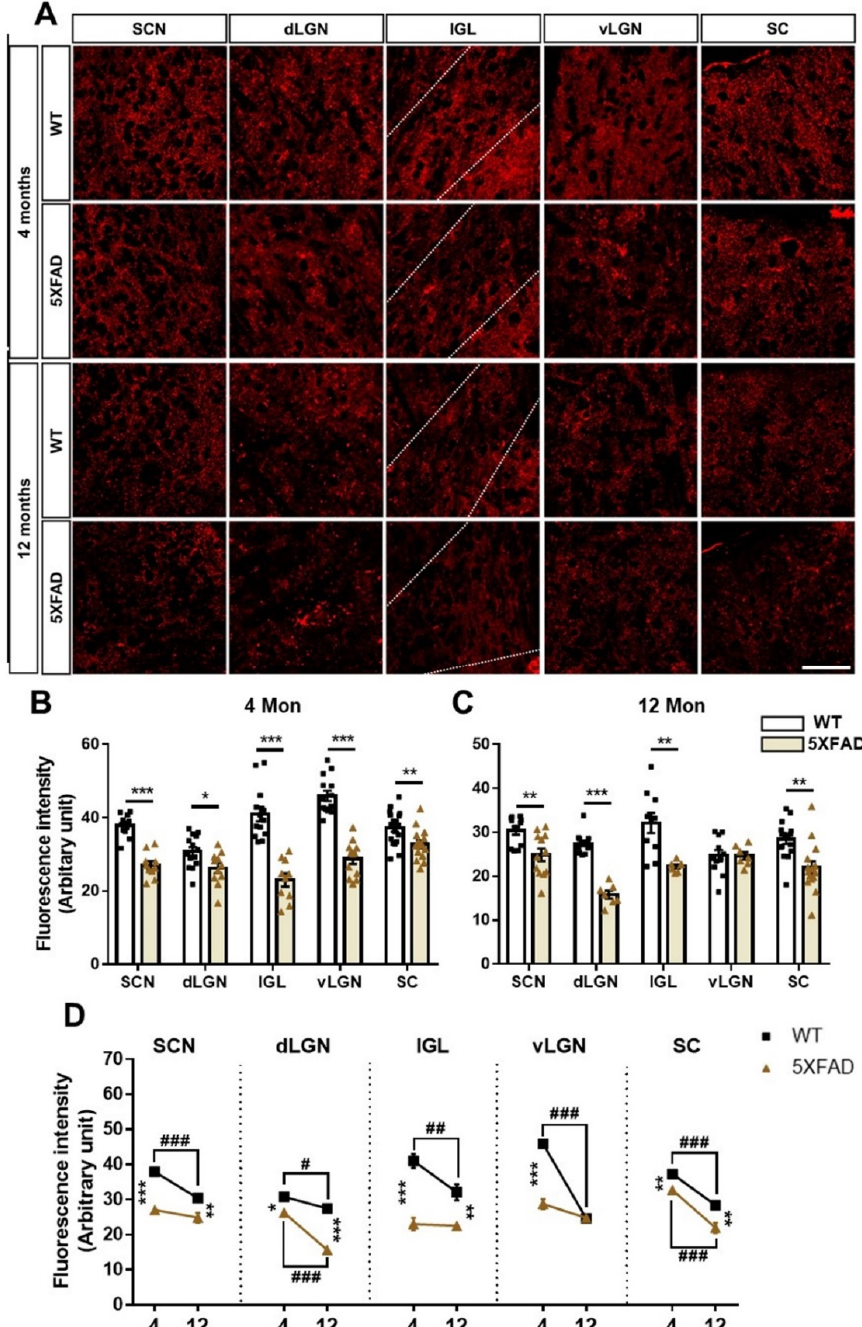
Figure 9. Synaptic degeneration in the retinorecipient area of the 5XFAD mice. ( A ) Representative images of pre-synaptic terminals in the SCN, dLGN, IGL, vLGN, and SC in the WT and 5XFAD mice. Pre-synaptic terminals were visualized using an anti-synaptophysin (SYN) antibody. The scale bar is 50 μ m. ( B , C ) The quantitative graphs exhibit the fluorescence intensity of SYN (+) areas in the SCN, dLGN, IGL, vLGN, and SC of WT and 5XFAD mice (7 − 18 images of the brain sections were obtained from 5 mice in each group). Statistical analysis was conducted by a multiple t -test. ( D ) Comparison of the synaptic loss by aging and AD progression. Statistical analysis was con- ducted by two-way ANOVA, followed by Tukey’s post hoc test. * p < 0.05, ** p < 0.01, *** p < 0.001, # p < 0.05, ## p < 0.01, and ### p < 0.001 indicate a significant difference.